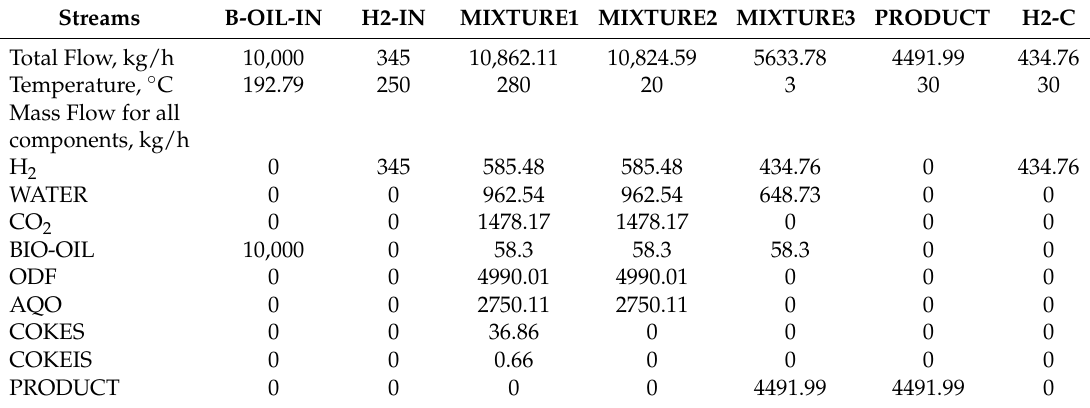
Table A2. Simulated results for main streams of products from mild hydrogenation of bio-oil at 280 ◦ C and 8 MPa and deep hydrogenation at 400 ◦ C and 15